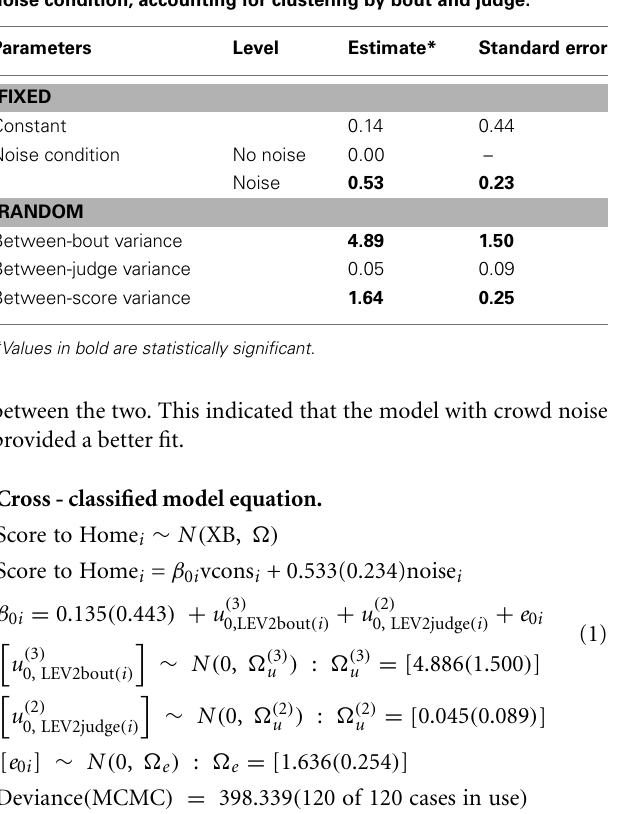
Table 1 | Cross-classified analysis of score in favor of home fighter by noise condition, accounting for clustering by bout and